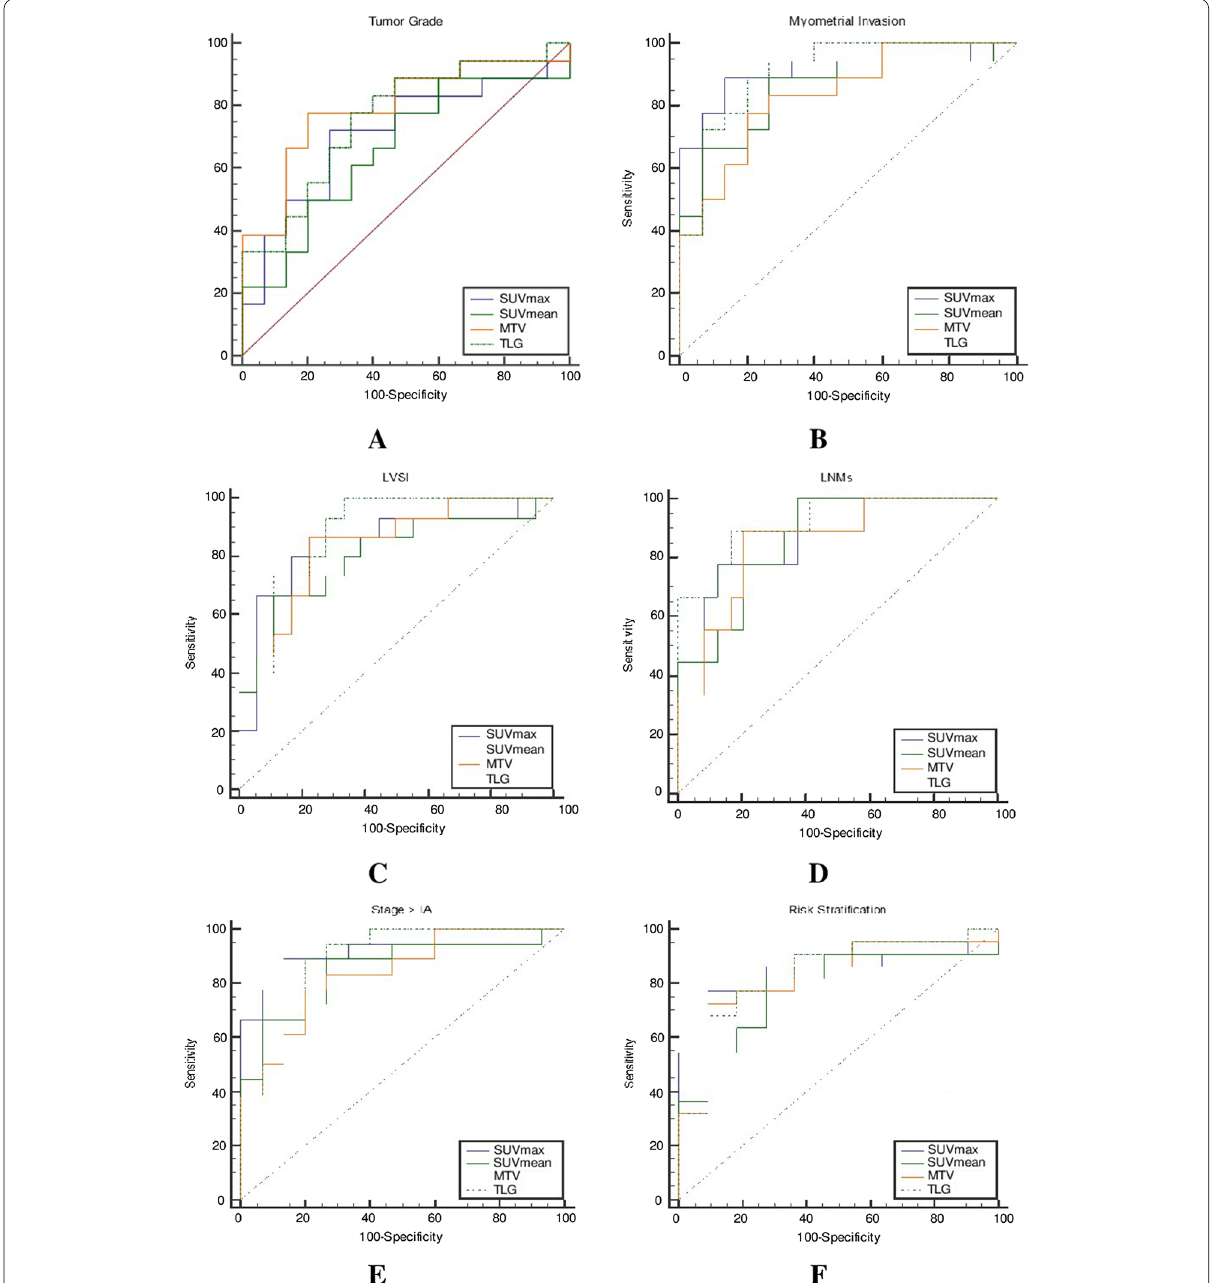
Fig. 4 ROC curves for various tumor quantifications for prediction of Tumor grade ( A ), MI ( B ), LVSI ( C ), LNMs ( D ), stage > IA ( E ), and risk stratification ( F ) in patients with endometrial